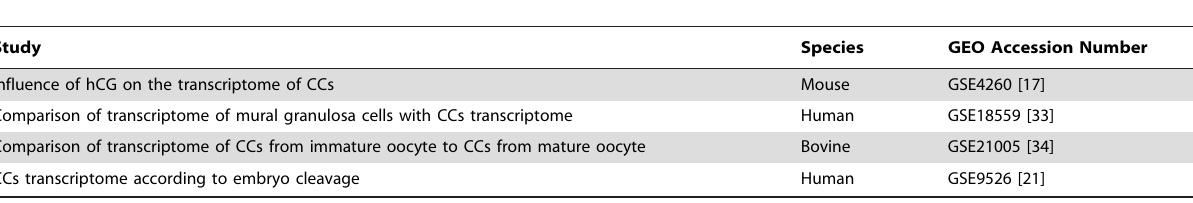
Table 1. Dataset of transcriptome of cumulus cells used for